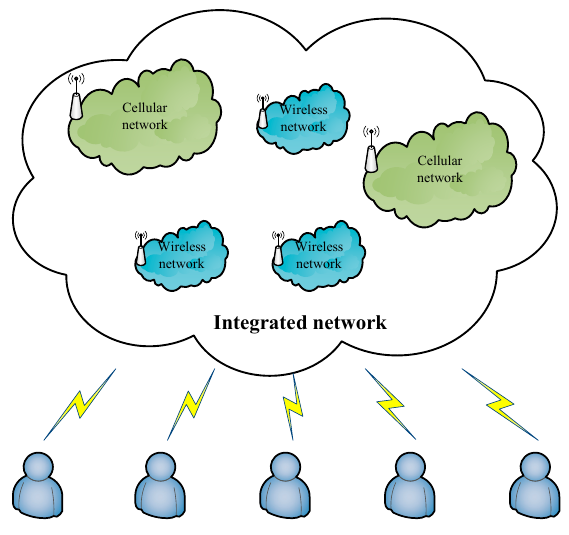
Figure 1. The integrated network model.